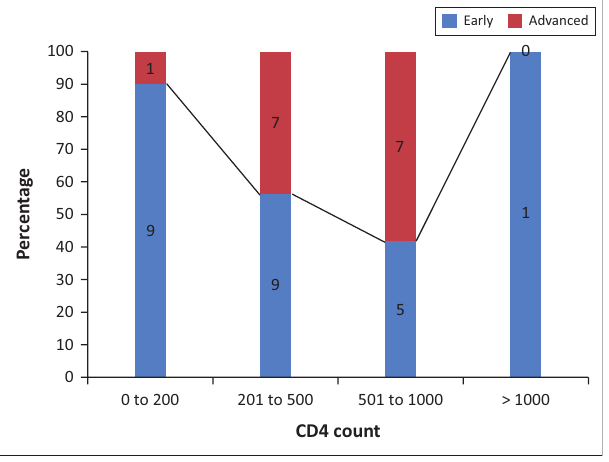
FIGURE 5: Ratio of patients presenting with early vs. advanced stage disease according to the CD4 count.